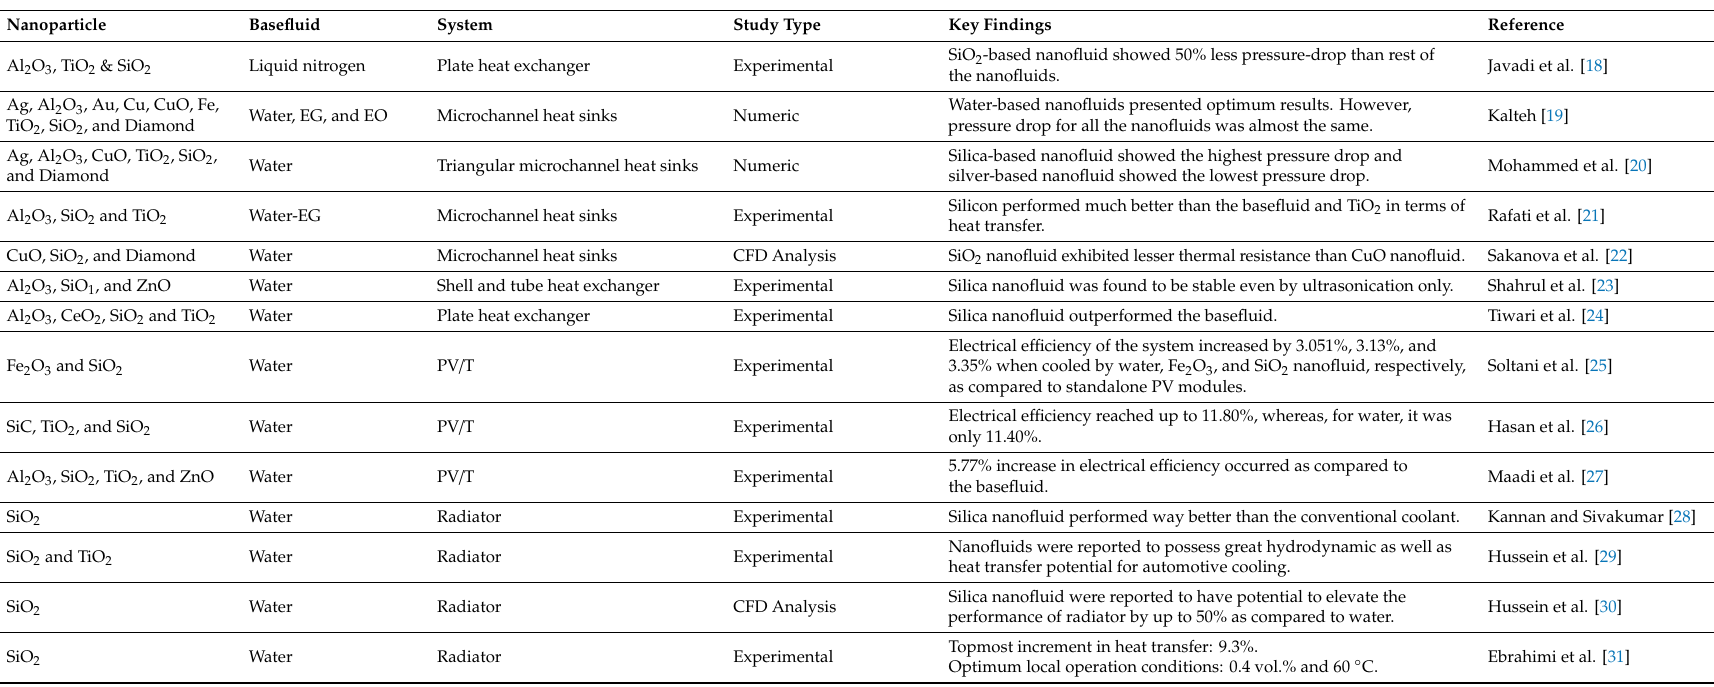
Table 1. Short review of studies using silica